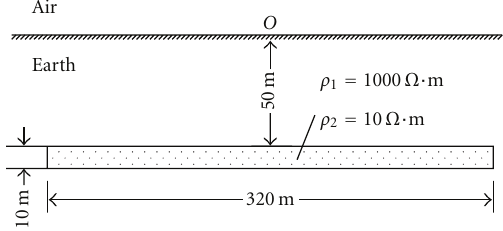
Figure 1: Example of the subdivision of a two-dimensional domain.